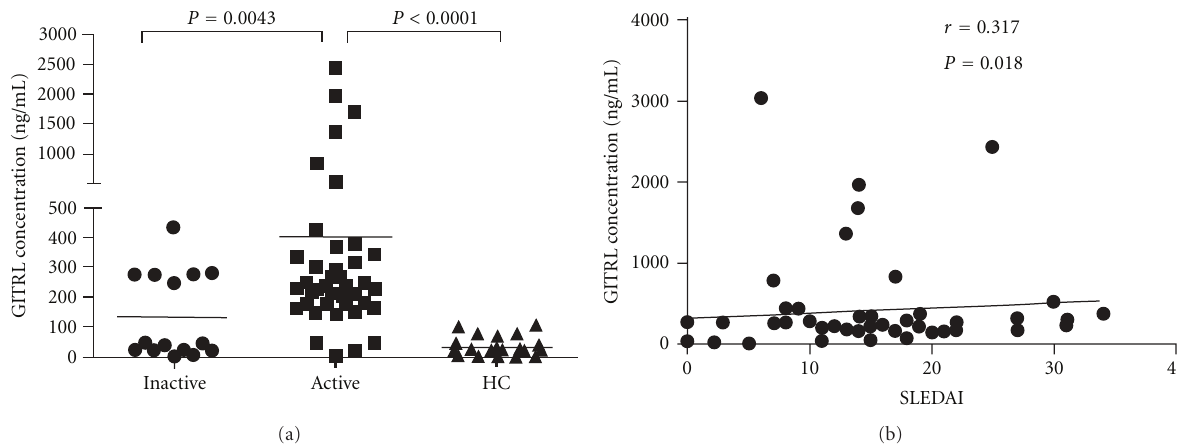
Figure 2: Comparison of serum GITRL levels among SLE patients with active disease and inactive disease as well as HC. (a) Serum GITRL levels were significantly elevated in SLE patients with active disease compared with those with inactive disease together with HC. (b) Serum GITRL levels were positively correlated with SLEDAI. Each symbol represents an individual patient and healthy donor; horizontal lines indicate median values. HC: healthy control; SLE: systemic lupus erythematosus.